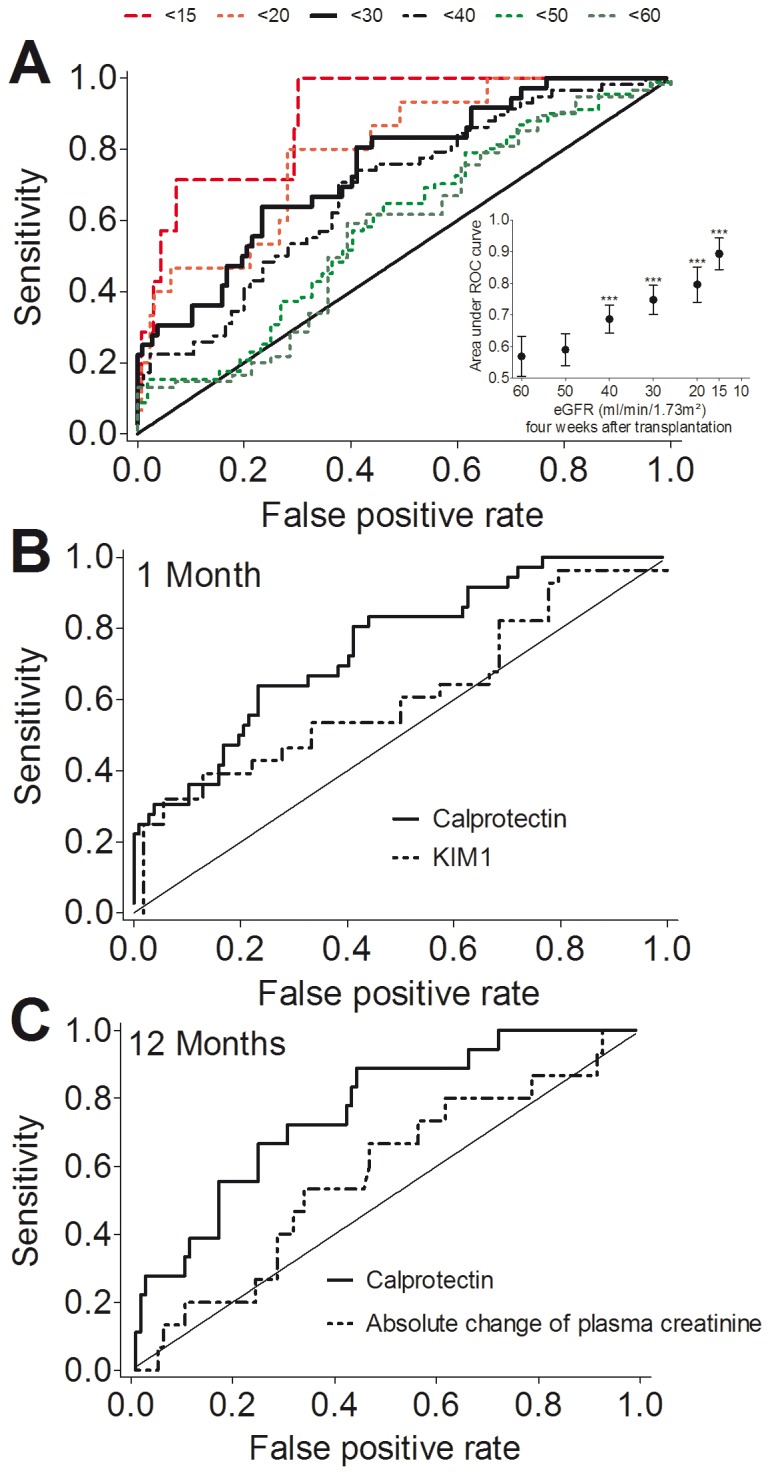
Calprotectin predicts kidney function.
A. Receiver-operating characteristic (ROC) curves and summary data (Inset) for area under curve showing that urinary calprotectin concentrations predicted impaired kidney function 4 weeks after transplantation. All analyses were performed in the entire population. eGFR after 4 weeks in mL/min/1.73 m2 are indicated in the legend above the curves. The inset indicates each area under curve per eGFR curve. ***P<0.001. B. Receiver-operating characteristic (ROC) curves for urinary calprotectin and urinary kidney injury molecule-1 (KIM-1) concentrations for predicting the eGFR in the lowest quartile (i.e., less than 30 mL/min/1.73 m2) 1 month after renal transplantation. C. Receiver-operating characteristic (ROC) curves for urinary calprotectin and absolute change of plasma creatinine for predicting the eGFR in the lowest quartile (i.e., less than 30 mL/min/1.73 m2) 12 months after renal transplantation.